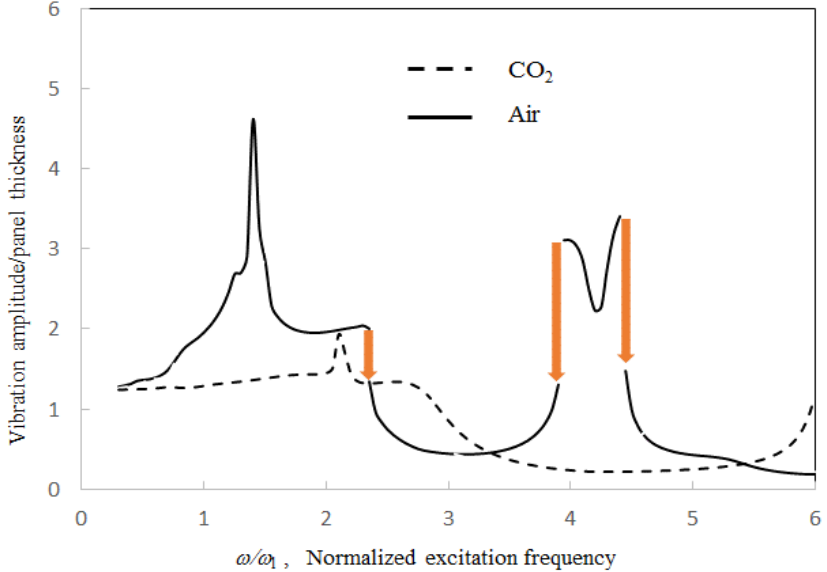
Figure 14. Vibration amplitude ratio versus normalized excitation frequency for the cases of air and CO 2 (number of structural modes = 2, number of acoustic modes = 4, l = 5 a , γ = 2, θ = 0; the orange arrows represent the “jump phenomenon”).